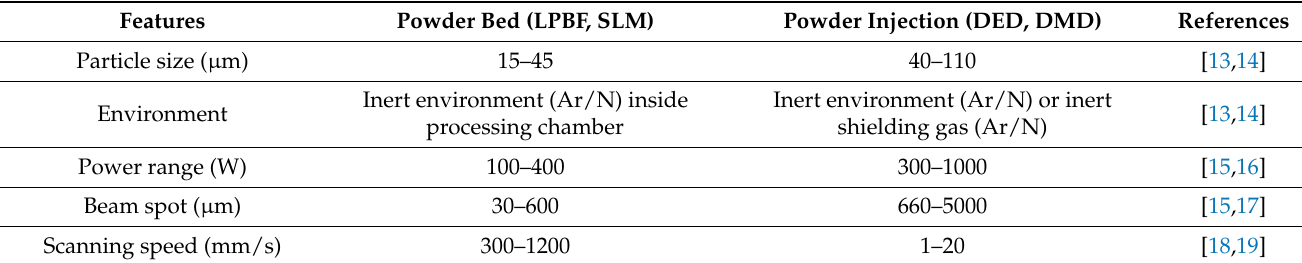
Table 1. Summary of built features in powder bed and powder injection metal AM